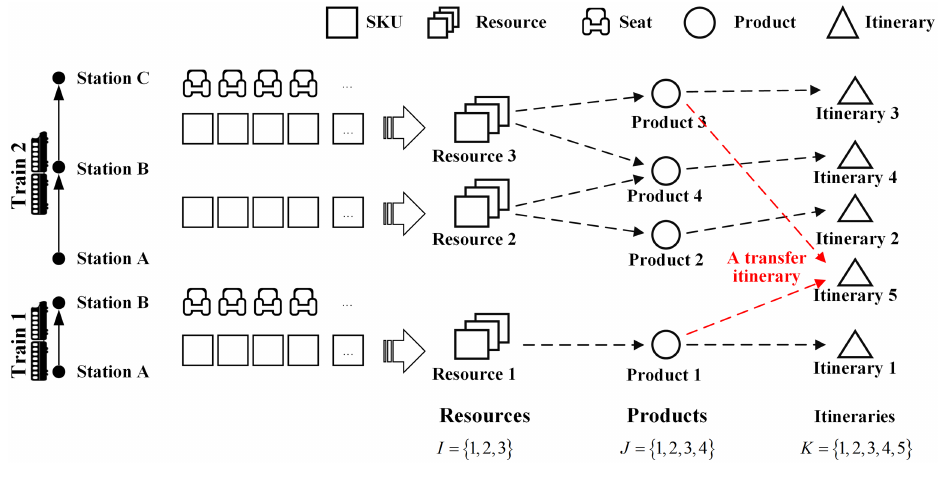
Fig 3. Elements in the example